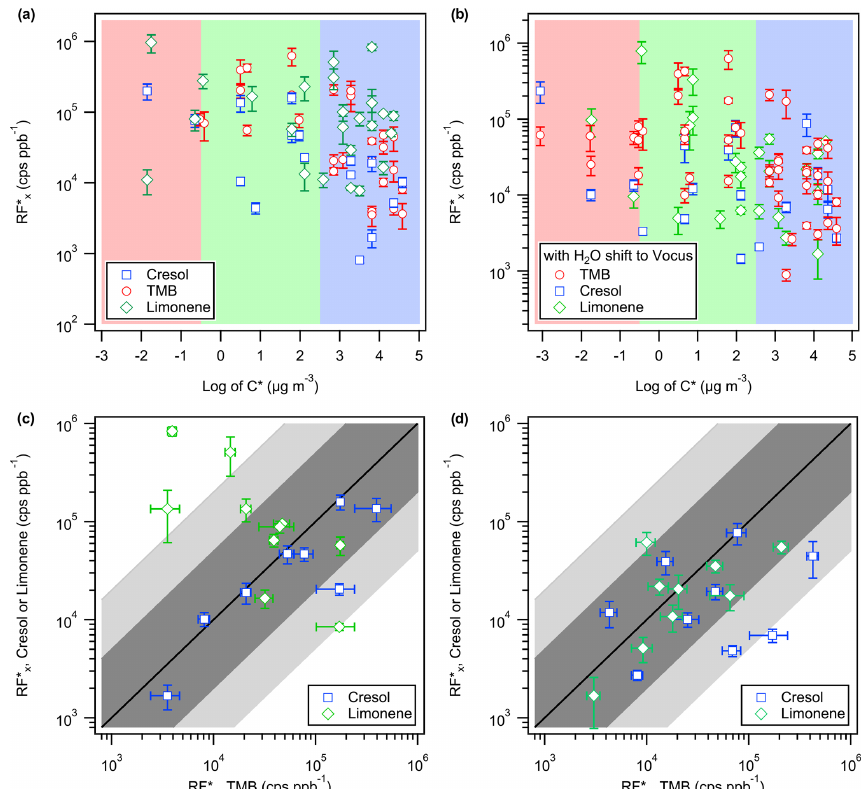
Figure 3. (a) The compound-dependent EESI-TOF response factor, RF ∗ x , of OH–TMB, OH–cresol, or O 3 –limonene oxidation products calculated as the linear regression slope of the observed rise in the particle-phase EESI-TOF ion intensity and the corresponding decrease in the gas-phase Vocus-PTR mixing ratio. From each reaction system, only oxidation products with R 2 ≥ 0 . 5 for the linear regression of EESI-TOF signal increase and Vocus-PTR mixing ratio decreases are shown. Red, green, and blue shading indicates the log (C ∗ ) range for low-volatility, semi-volatile, and intermediate-volatility organic compounds, respectively. Ion fragmentation in the Vocus-PTR is assumed to be negligible. (b) Same as (a) , except that it is assumed that all ions undergo − H 2 O loss in the Vocus-PTR. (c) Comparison of the RF ∗ x for analytes with an identical molecular formula observed in different systems. The 1-to-1 line is shown in solid black. Ion fragmentation in the Vocus-PTR is assumed to be negligible. (d) Same as (c) , except that it is assumed that all ions undergo − H 2 O in the Vocus-PTR. The lighter- and darker-shaded regions represent deviations of a factor of 20 and 5, respectively, from the 1-to-1 line. The error bars shown correspond to the uncertainties in the fitted